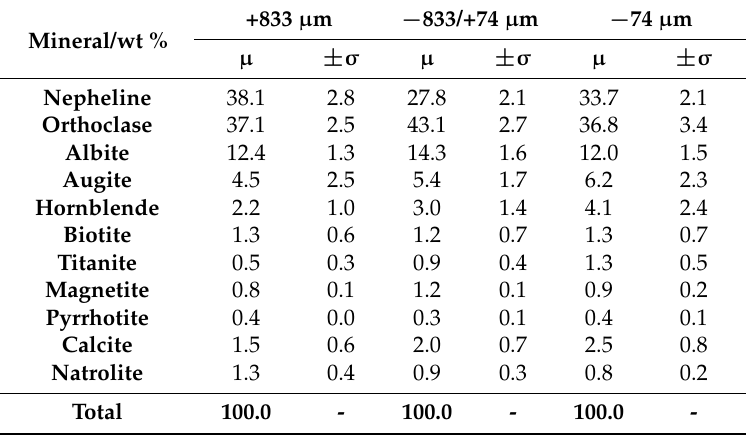
Table 4. Average and standard deviation of the Rietveld XRD mineralogy for all samples, for the fraction +833, − 833/+74, and − 74 µ m. +833 µ Mineral/wt %